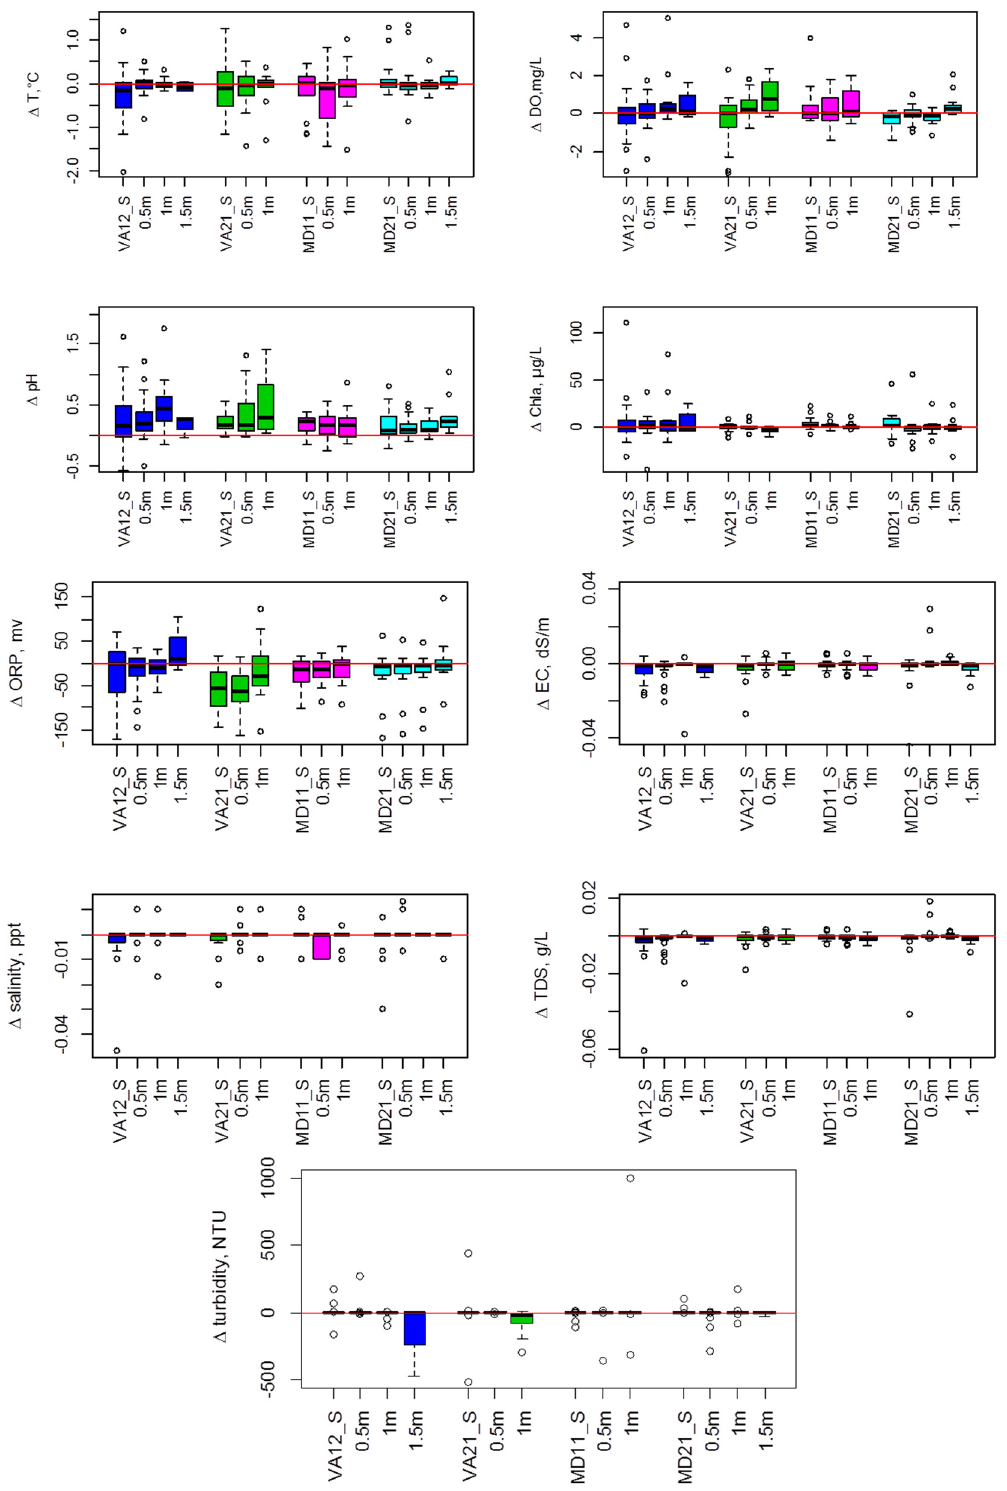
Figure 2. Boxplots of water quality difference between the middle and the entrance of reservoir VA12, VA21, MD11 and MD21 at various water depths. Each boxplot represents the median (solid line), 25th and 75th percentile (box) and 10th and 90th percentile (error bar) for water quality differences at each depth in RIRs investigated during 2011 to 2014. Data above the red solid line indicate higher water quality parameter values in the middle than at the entrance, and vice versa